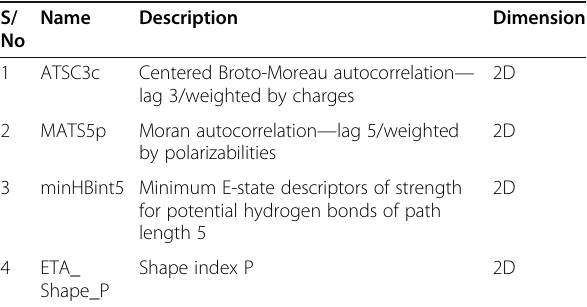
Table 3 List of descriptors, their constructors, description and dimension used in building the QSAR model